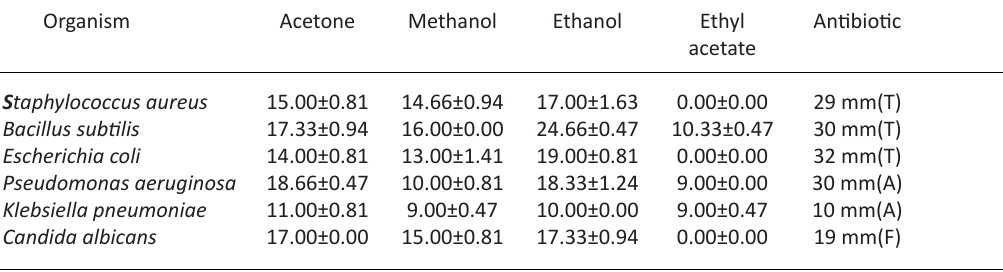
Table 1. Antibacterial activity of fruit pulp (with seeds) and zones of inhibition (mm) Organism Acetone